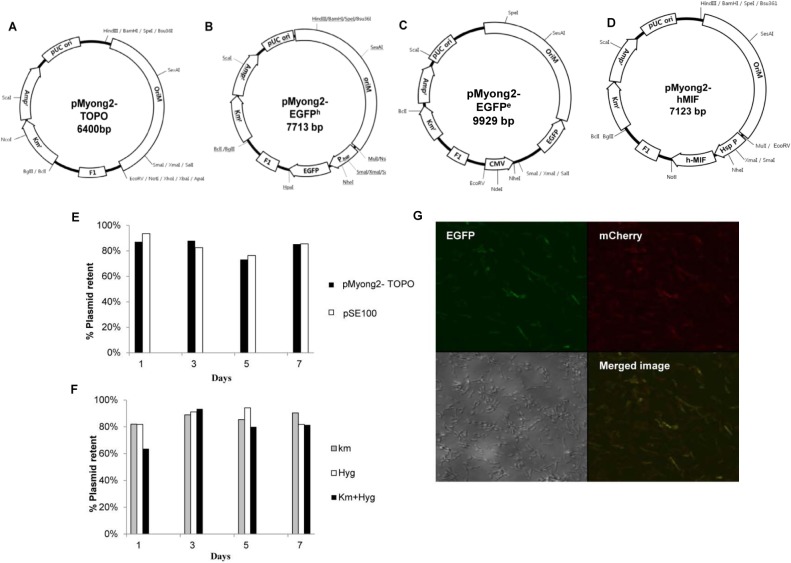
Maps of Mycobacterium—E. coli shuttle vectors harboring the pMyong2 vector system, and the stability and compatibility of the pMyong2-TOPO vector system.(A) Maps of the pMyong2-Topo vector, which replicates in mycobacteria and E. coli, (B) pMyong2-EGFPh expressing EGFP under the mycobacterial hsp65 promoter, (C) pMyong2-EGFPe expressing EGFP under the CMV promoter, and (D) pMyong2-hMIF expressing the hMIF gene under the mycobacterial hsp65 promoter. (E) M. smegmatis, carrying the pMyong2-TOPO (black column) or pSE100 (empty column) vectors, was plated onto 7H10 agar medium supplemented with antibiotics. (F) M. smegmatis carrying pMyong2-TOPO and pSE100 vectors was plated onto 7H10 agar medium supplemented with either or both antibiotics (gray column, kanamycin;empty column, hygromycin;black column, kanamycin and hygromycin). (G) M. smegmatis co-transformed with pAL5000-mCherry and pMyong2-EGFP-Hyg vectors was observed using confocal microscopy. Abbreviations: Ampr, ampicillin resistance; Kmr, kanamycin resistance; pUC ori, bacterial origin of replication; oriM, mycobacterial origin of replication; CMV, cytomegalovirus promoter from pIRES2-EGFP vector; EGFP, EGFP gene from pIRES2-EGFP vector; Phsp, hsp65 promoter from M. bovis BCG; Km, kanamycin; Hyg, hygromycin.